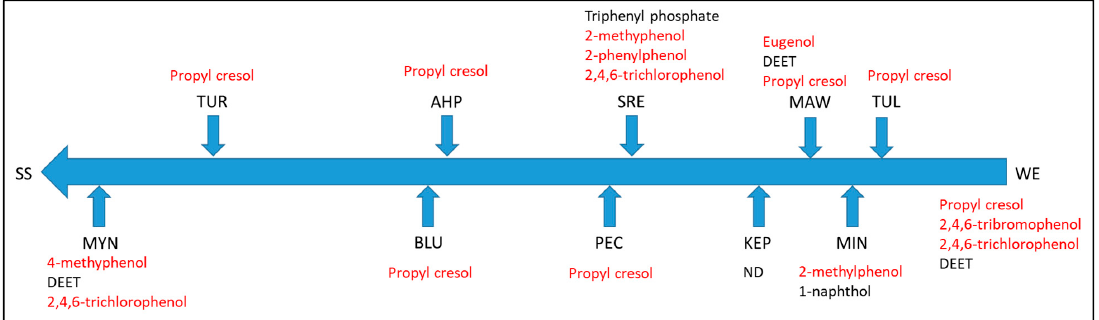
Figure 2. Suspect screening results for GC-Q/TOF-MS data.